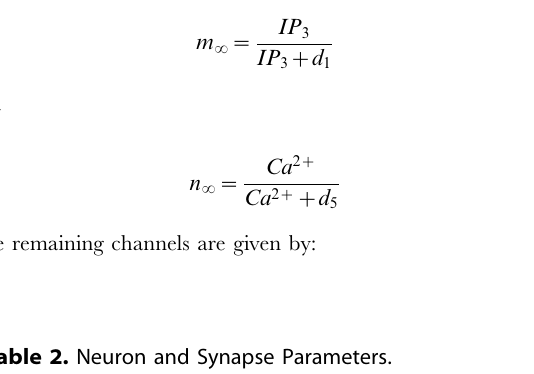
Table 2. Neuron and Synapse Parameters.